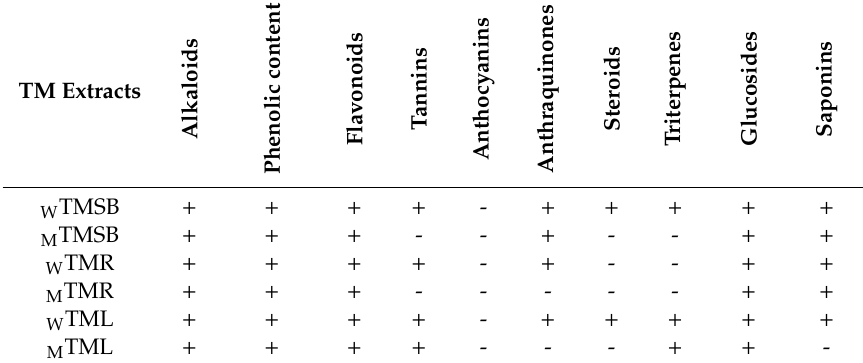
Table 1. Analysis of phytochemical composition in Terminalia mantaly (TM)